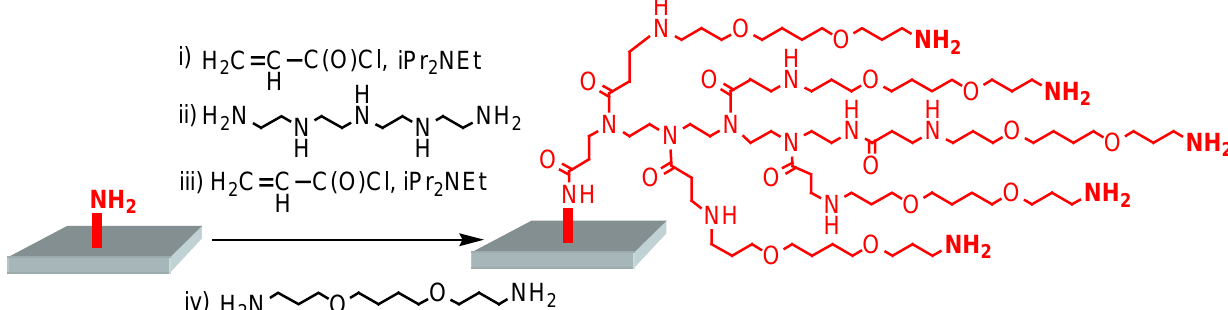
Figure 3. Synthesis of a dendritic linker structure, for multiplying the number of reactive site for attachment of nucleic acids. A mixture of dendritic structure is created by this procedure, only one type is shown.